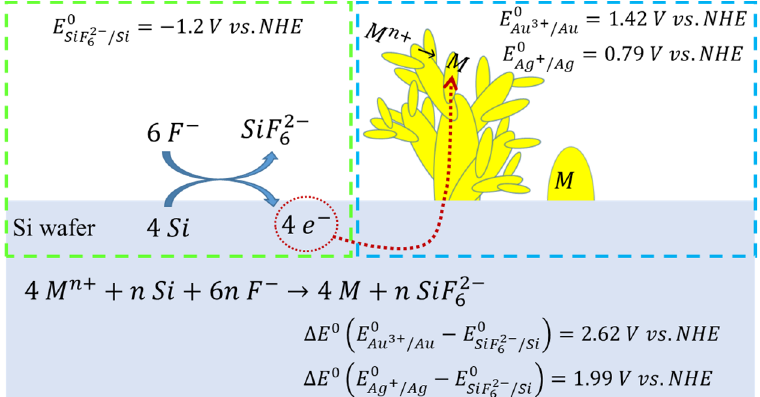
Figure 1. Schematic of the Au@Ag-DNFs/Si Galvanic replacement reaction.